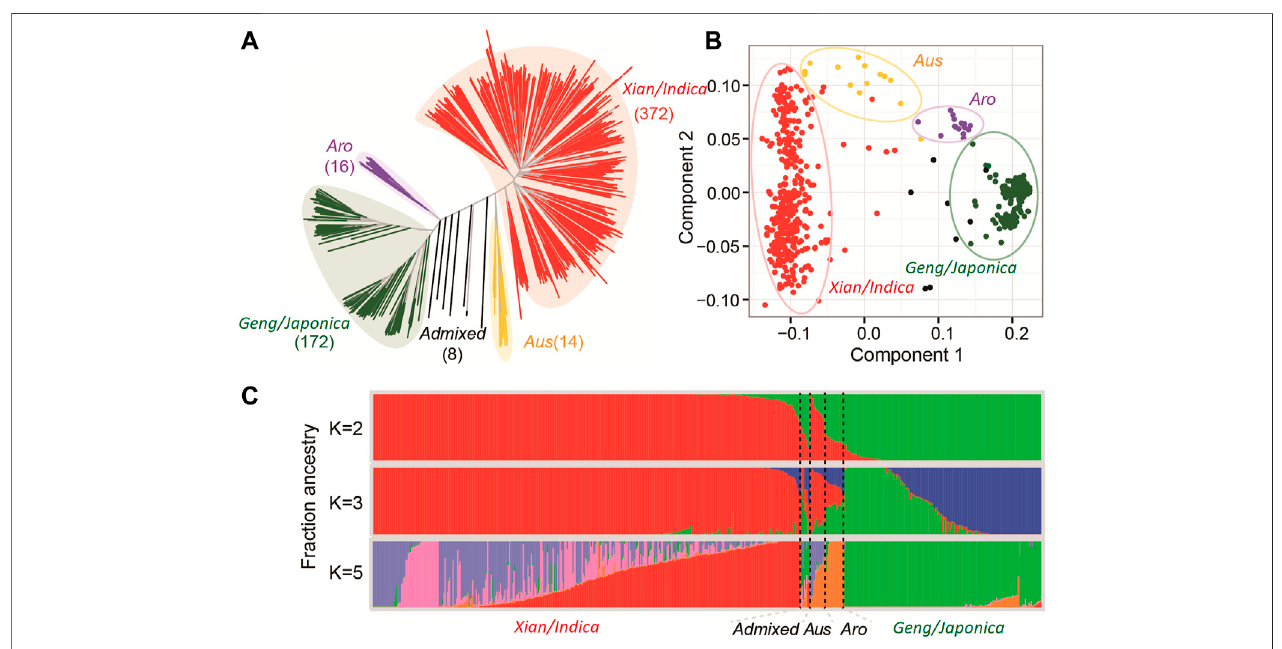
FIGURE 1 | Population structure of germplasm showing NJ tree plot (A) , PC (B) , and Bayesian clustering (C) of germplasm.